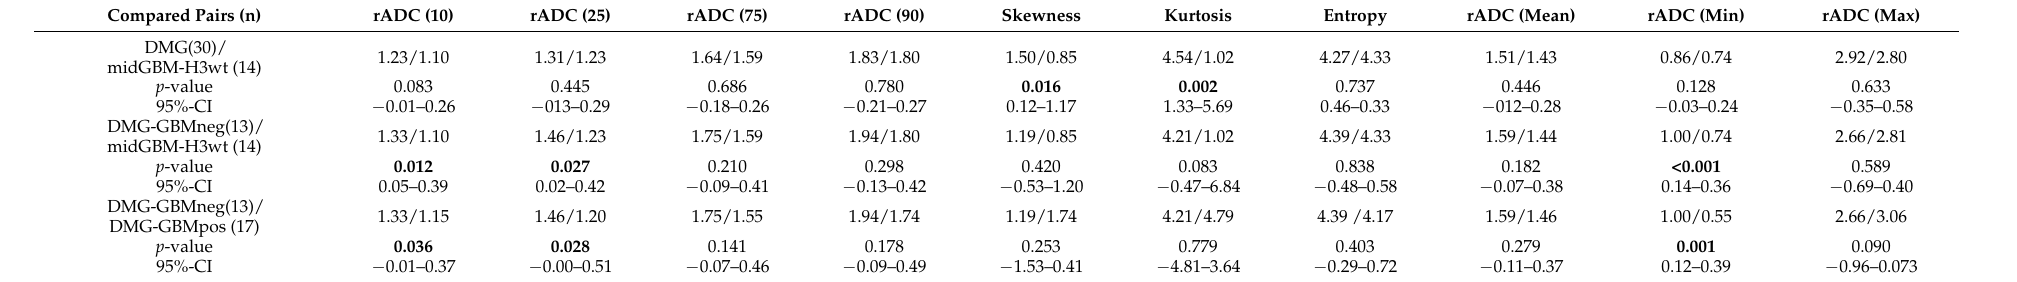
Table 2. Distribution of relative ADC histogram parameters and relative mean, minimum and maximum ADC values among the two tumor entities and the DMG-subtypes.